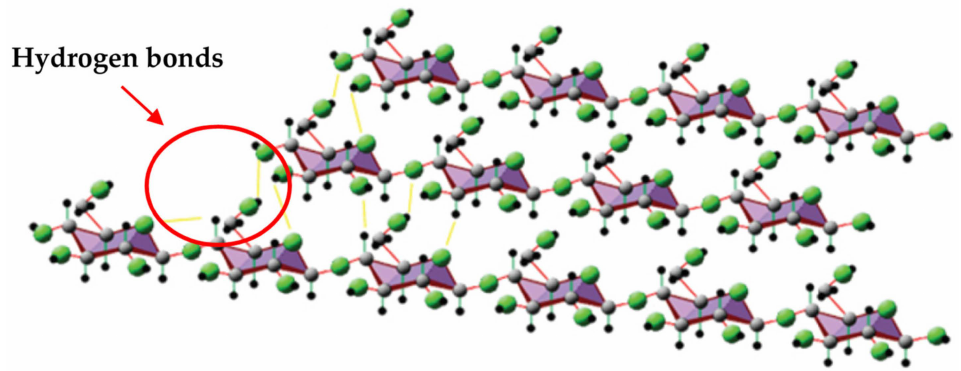
Figure 13. Hydrogen bonds interaction between β -glucose molecules in a segment of cellulose. Reproduced with permission from Compos. from Renew. Sustain. Mater. , P é rez-Pacheco et al.,